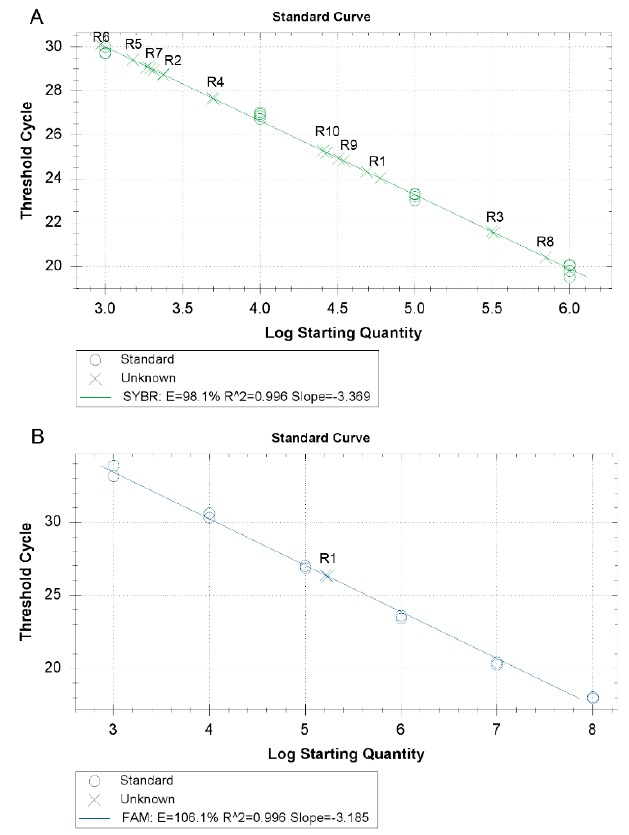
Figure 2. ( A ) Rickettsia species amplification by the new SYBR Green RT-PCR for the ompB gene and ( B ) the new TaqMan RT-PCR for the ompA gene. (R1: R. conorii ; R2: R. aeschlimannii ; R3: R. massiliae ; R4: R. raoultii ; R5: R. monacensis ; R6: R. helvetica ; R7: R. slovaca ; R8: R. felis ; R9: Rickettsia endosymbiont of Haemaphysalis sulcata ; and R10: Candidatus Rickettsia hoogstraalii) Table 1. Results of the amplification with the two new methods in the presence of DNA from different Rickettsia species and from other tick-borne pathogens.